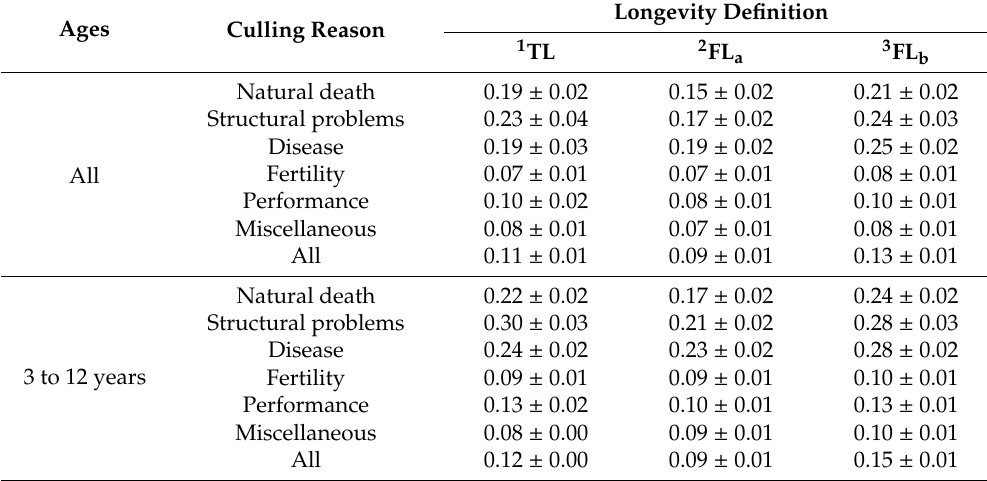
Table 3. Average heritabilities ( ± SE) estimated considering all ages (i.e., from 2 to 15 years) and ages between 3 and 12 years-old, for all longevity definitions and culling reasons.